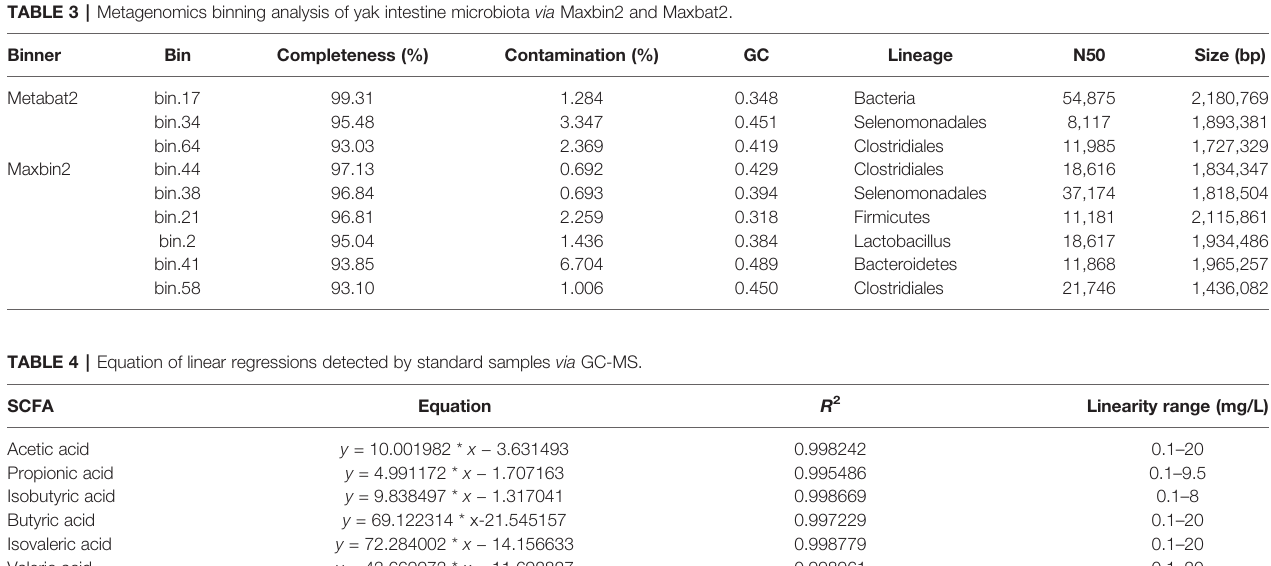
TABLE 3 | Metagenomics binning analysis of yak intestine microbiota via Maxbin2 and Maxbat2. Binner Bin